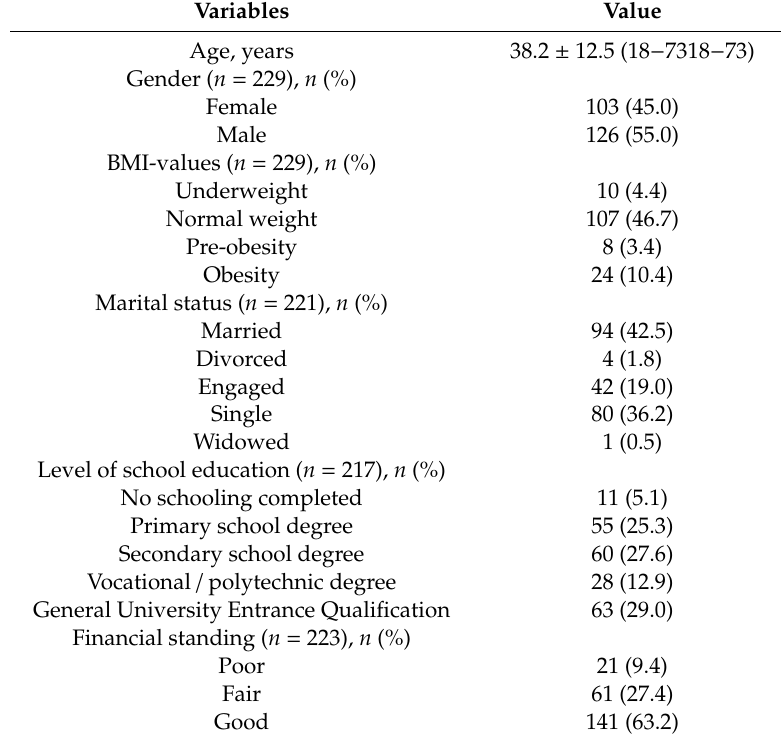
Table 1. Sociodemographic